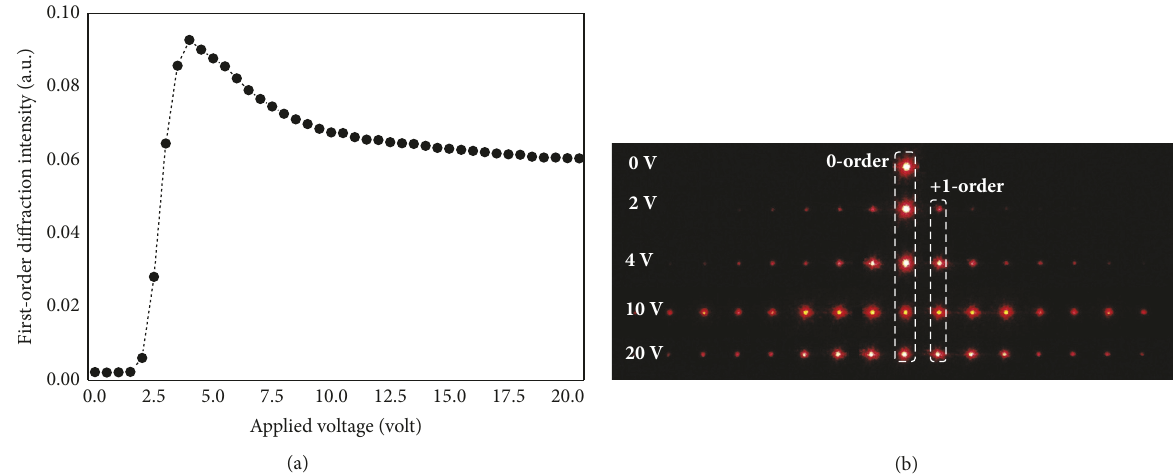
Figure 3: (a) The first-order diffraction intensity versus voltage for a liquid crystal phase grating formed from the periodic grating-like electrodes cell. (b) Diffraction patterns at different applied voltages: 0, 2, 4, 10, and 20 V, respectively.